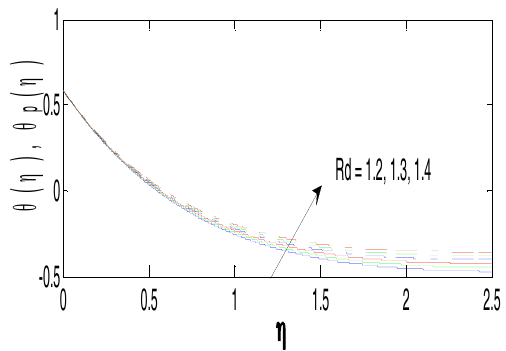
Figure 8. Imapct of Rd on temperature profile θ and θ p of fluid with dusty particles.